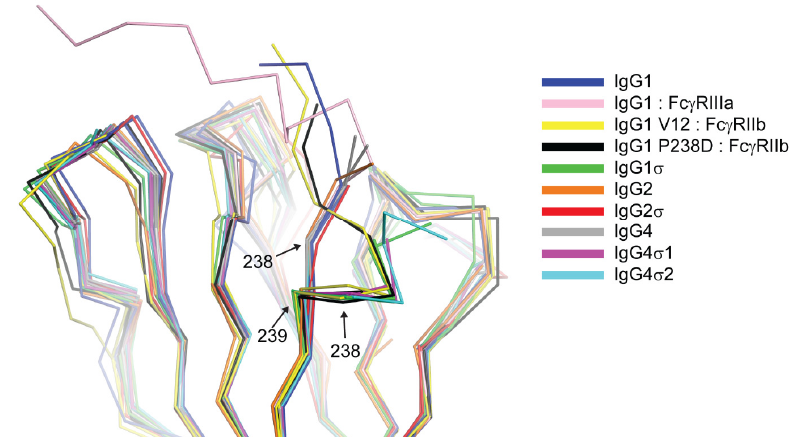
Figure 12. Structural consequence of mutation at position 238 reveals an altered conformation of the lower hinge. Backbone alignment of Fc C H 2 domains of huIgG1 (Protein Data Bank (PDB) 3AVE [40]), huIgG1 in complex with Fc γ RIIIa (chain B, PDB 3SGJ [47]), huIgG1 V12 variant in complex with Fc γ RIIb (PDB 3WJL [48]), huIgG1 P238D in complex with Fc γ RIIb (PDB 3WJJ [48]), huIgG1 σ , huIgG2 (PDB 4HAF [49]), huIgG2 σ (PDB 4L4J [29]), huIgG4 (PDB 4C54 [50]), huIgG4 σ 1, huIgG4 σ 2. The C α positions of residues 238 and 239 are labeled.